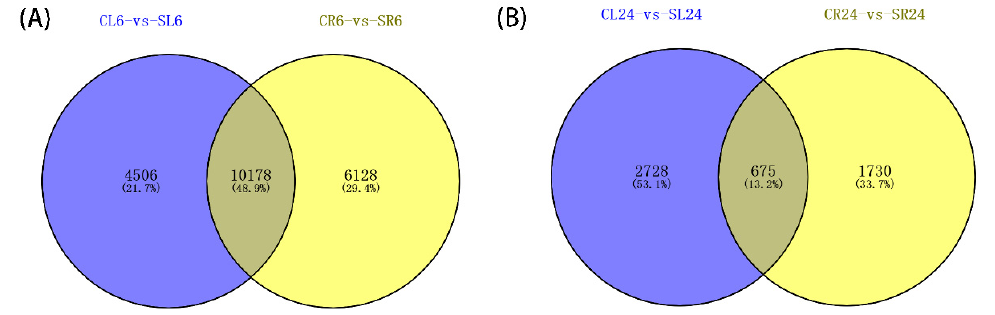
Figure 1. Venn diagrams showing DEGs in A. canescens under salt treatments. Blue and yellow colors represent leaf and root transcripts under 100 mM NaCl treatment for ( A ) 6 h and ( B ) 24 h, respectively. C and S represent the control conditions and 100 mM NaCl treatment, respectively; L and R denote the leaves and roots, respectively; and 6 and 24 denote the treatment durations.